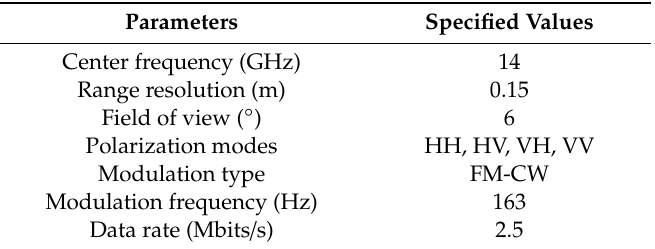
Table 2. Main parameters of Tomoradar. FM-CW: Frequency Modulated Continuous